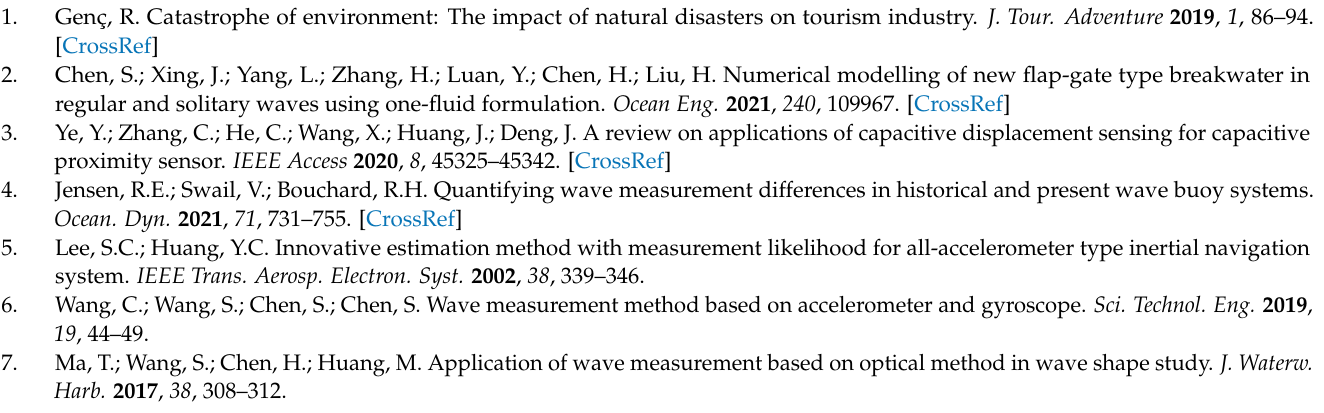
Figure 11. Nonlinear characteristic quantity varies with period distribution. (The prefix T indicates the calculated value in the time domain, and the prefix S indicates the calculated value in the spatial domain).